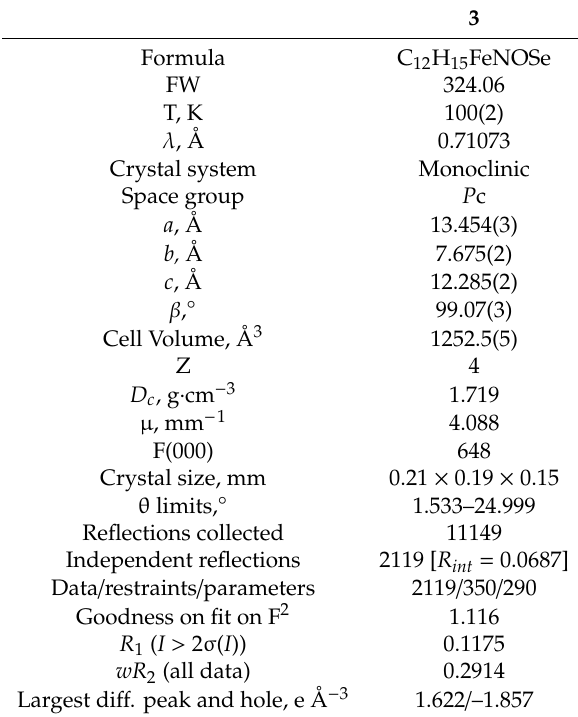
Table 5. Crystal data and measurement details for 3